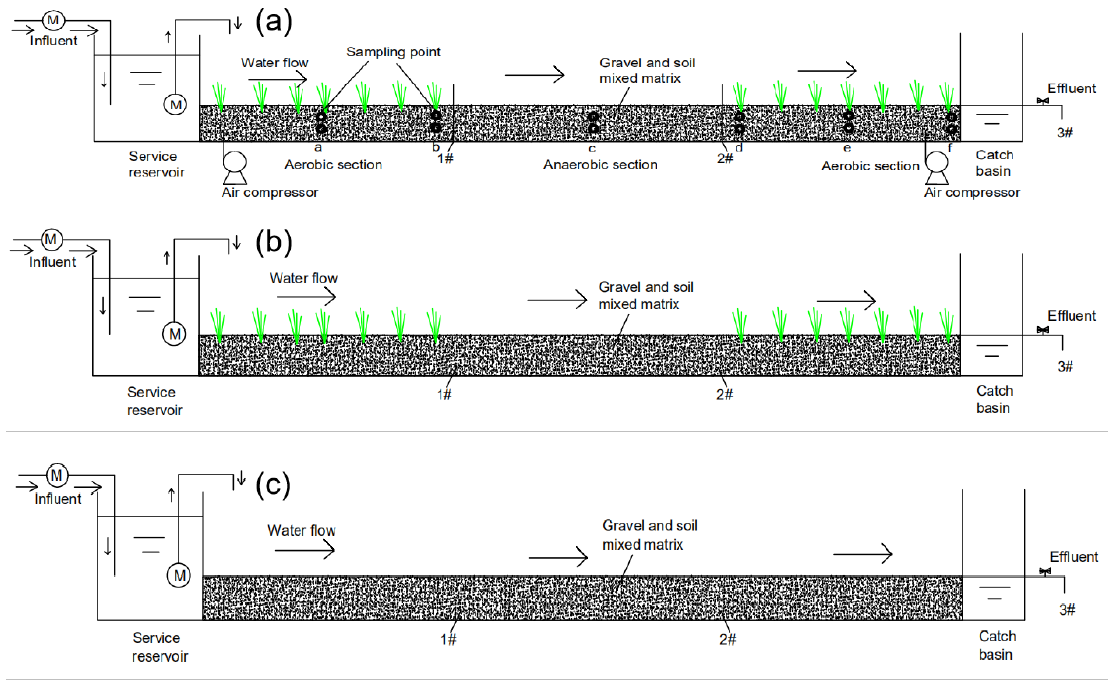
Figure 1. The diagram of the three groups of constructed wetlands, ( a ) O-A-O (aerobic/anaerobic/ aerobic) water spinach wetland, ( b ) Common matrix flow wetland, ( c ) No-plant wetland.